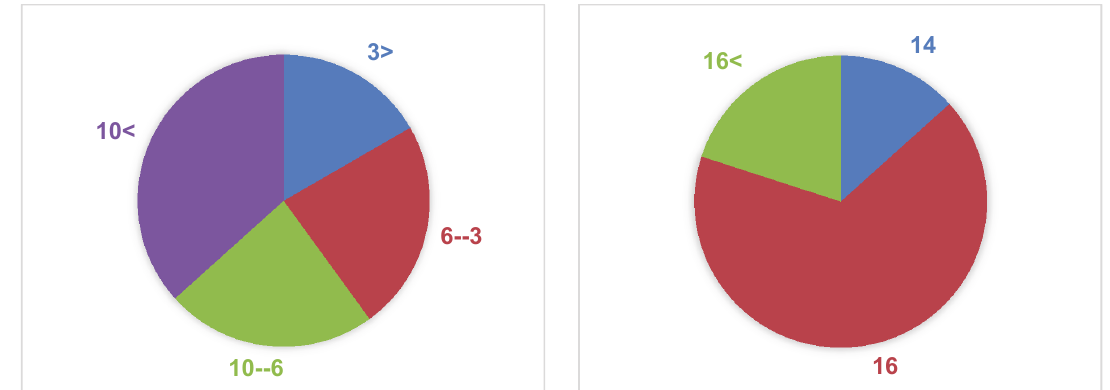
Fig. 1. Personal characteristics of the